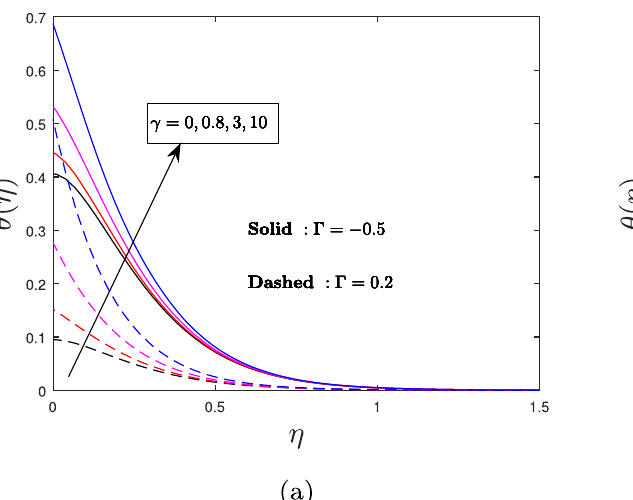
Figure 13: Behaviour of ( a ) regular fl uid, SNF, HNF, MNF and ( b ) ϕ